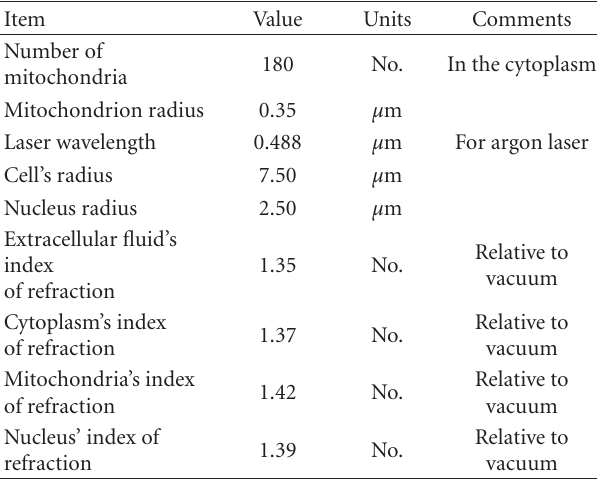
Table 1: Summary of simulation